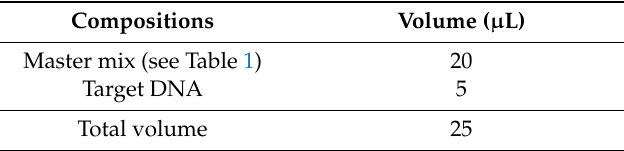
Table 2. Reaction volume with target and master